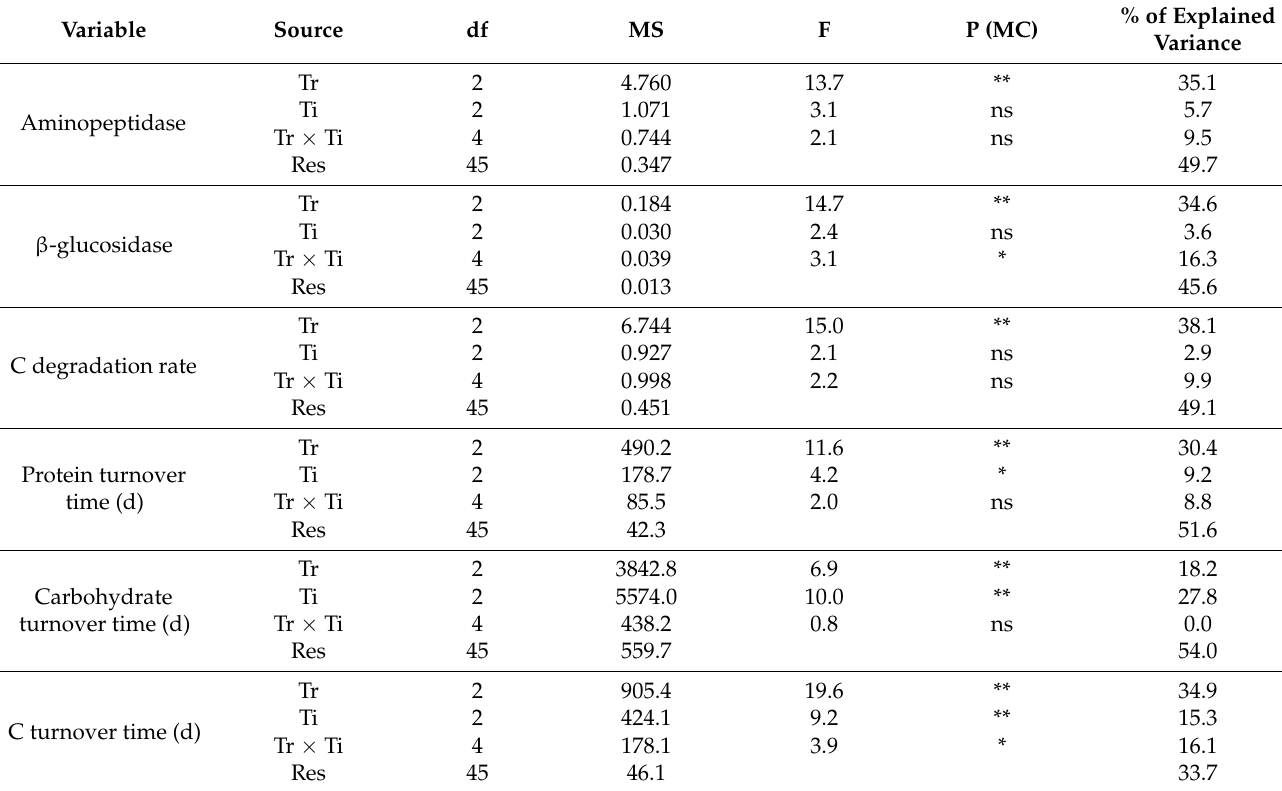
Table 3. Results of PERMANOVA testing for differences in extracellular enzymatic activities, C degradation rates and turnover time among treatments (Tr: CTRL, MT and HT) and sampling times (Ti: T 0 , T 1 and T 2 ) Df = degrees of freedom; MS = mean square; F = statistic F; ** = p < 0.01; * = p < 0.05; ns = not significant. Reported is also the percentage of variation explained by each factor, their interaction and residual (Res; unexplained) variance. P (MC) = probability level after Monte Carlo simulations and 999